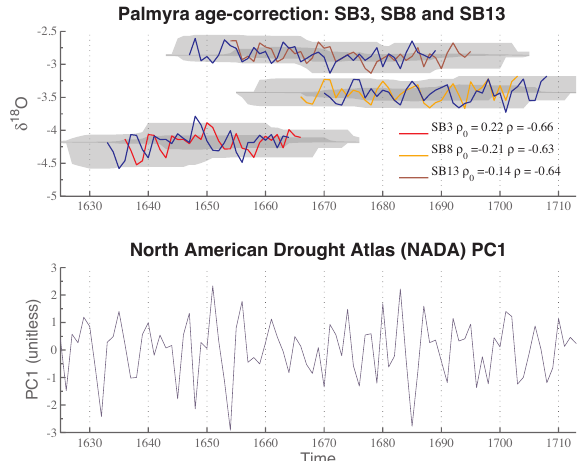
Fig. 4. Palmyra relict coral δ 18 O records (top): published data SB3 in red, SB8 in orange and SB13 in brown (Cobb et al., 2003); the shaded area is the 95% confidence interval of the ensemble of re- alizations with final time shifted t f ± 10years and θ 1 = θ 2 = 0 . 05, and the blue chronology corresponds to the realizations that maxi- mize the correlation with the first principal component of the NADA record (bottom) over each continuous section. For SB3, there were 2 added years and 2 removed years, and t f was shifted by − 2years. For SB8, there were 2 added years and 2 removed years, and t f was shifted by 5years. For SB13, there were 1 added year and 2 removed years, and t f was shifted by − 6years. The correlation co- efficients with NADA PC1 are also shown, wherein ρ is computed using the aligned Palmyra chronologies, and ρ 0 using the original